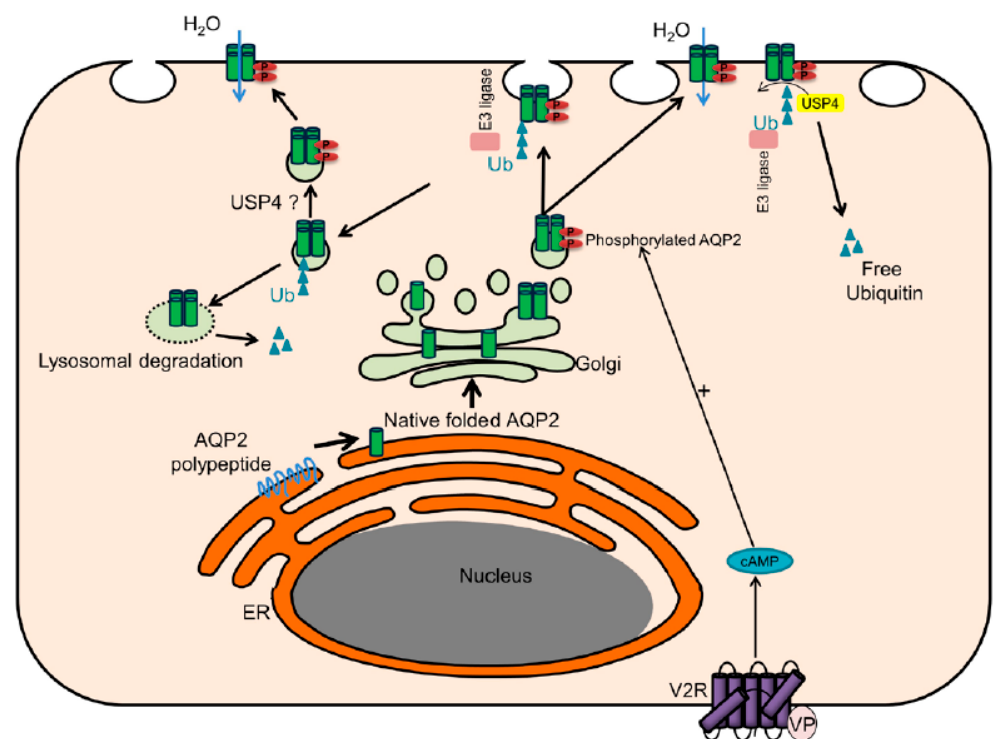
Figure 6. Potential regulation of AQP2 by USP4. Natively folded AQP2 traffics to the Golgi apparatus, is organized into tetramers, and stored in transport vesicles. Following vasopressin (VP) stimulation of the V2R, AQP2 traffics to the plasma membrane (PM) and is phosphorylated at Ser/Thr269, which stimulates AQP2 interaction with USP4. This interaction limits the degree of AQP2 ubiquitylation and allows AQP2 to accumulate on the plasma membrane. Alternatively, following AQP2 internalization, USP4 activity determines whether AQP2 is deubiquitylated and recycled to the PM, or targeted for lysosomal degradation. A number of collecting duct specific E3 ligases may be involved in these processes. Note, the relationship of ubiquitylation and phosphorylation of AQP2 within a tetramer is unknown and the figure does not aim to depict a specific stoichiometry.